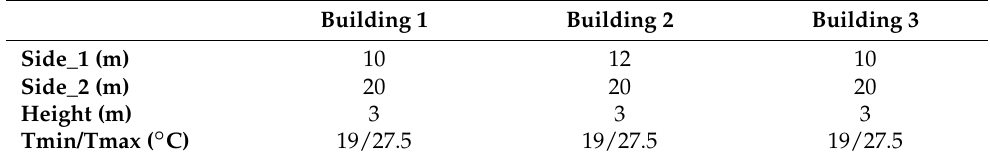
Table 1. Thermal zones’ characteristics.